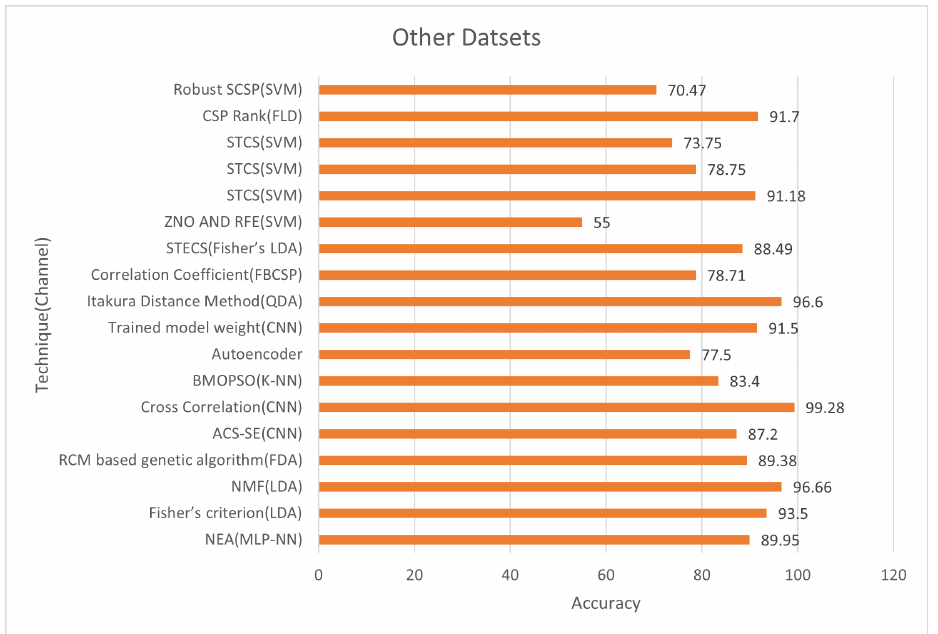
Figure 12. Selected channels by different techniques for Dataset IIa BCI Competition IV.